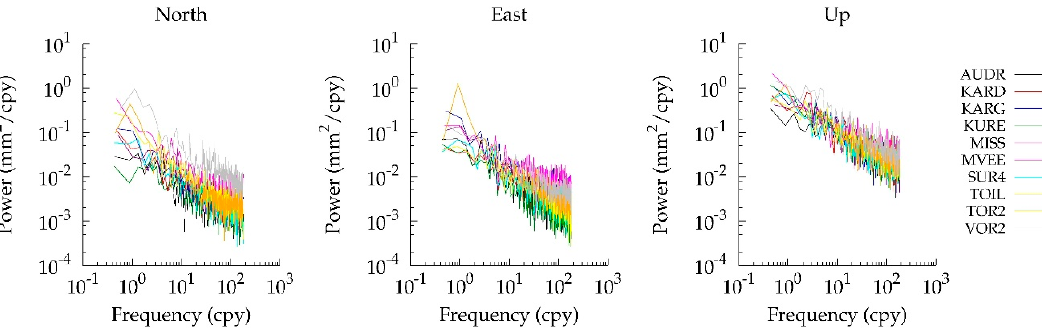
Figure 5. Power spectral densities of the time-series residuals of station TOIL based on the solution GOA_2. Figure 6. Power spectral densities of the time-series residuals of station MISS based on the solution BERN_2. Since the visual selection of the best fitting noise model can be ambiguous, relative goodness of the noise models were estimated based on the AIC and BIC values provided by Hector Table 3 and Table 4 show how many times the corresponding noise model had the lowest AIC or BIC value for